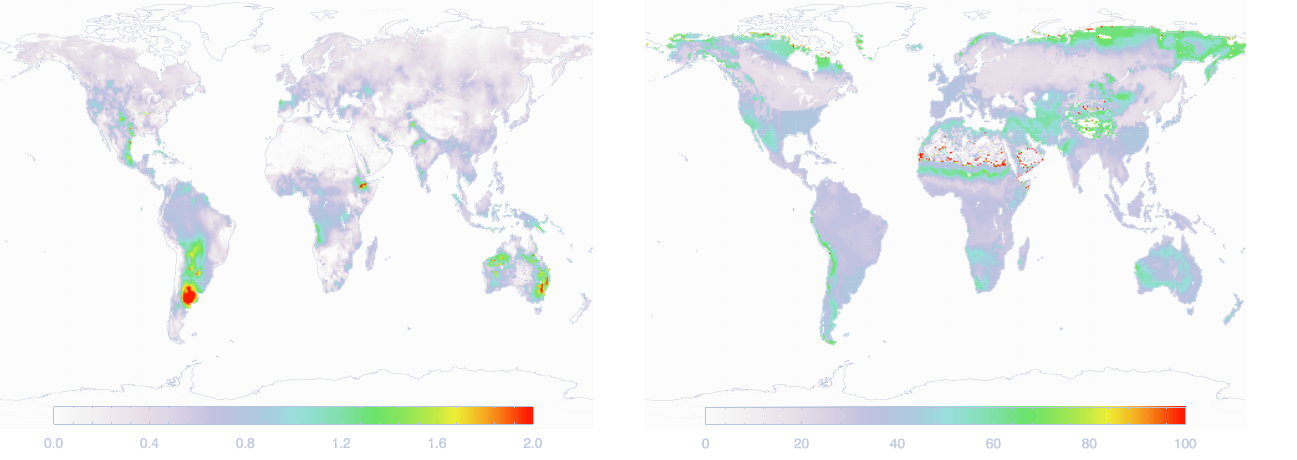
Figure 7. Geographic distribution of the percentage of NPP sup- ported by newly fixed